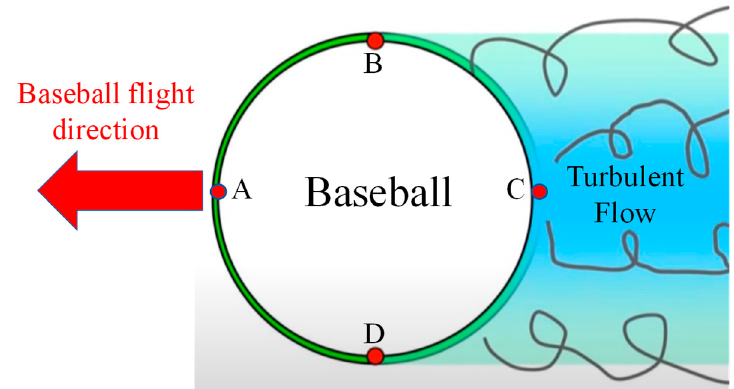
Figure 2. Analysis of Ludwig Prandtl’s boundary-layer theory during baseball flight.